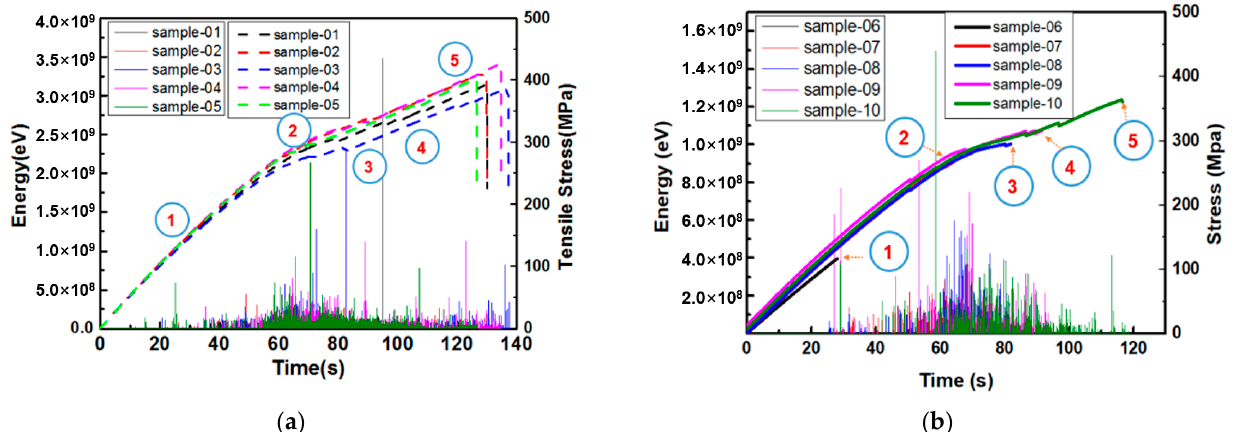
Figure 8. AE data repeatability and the phased experiments scheme ( a ) and results of the phased experiments ( b ). Table 3. The correspondence between the phased samples and the stress levels. Phase Points Corresponding Samples Stress Levels ( σ / σ s)